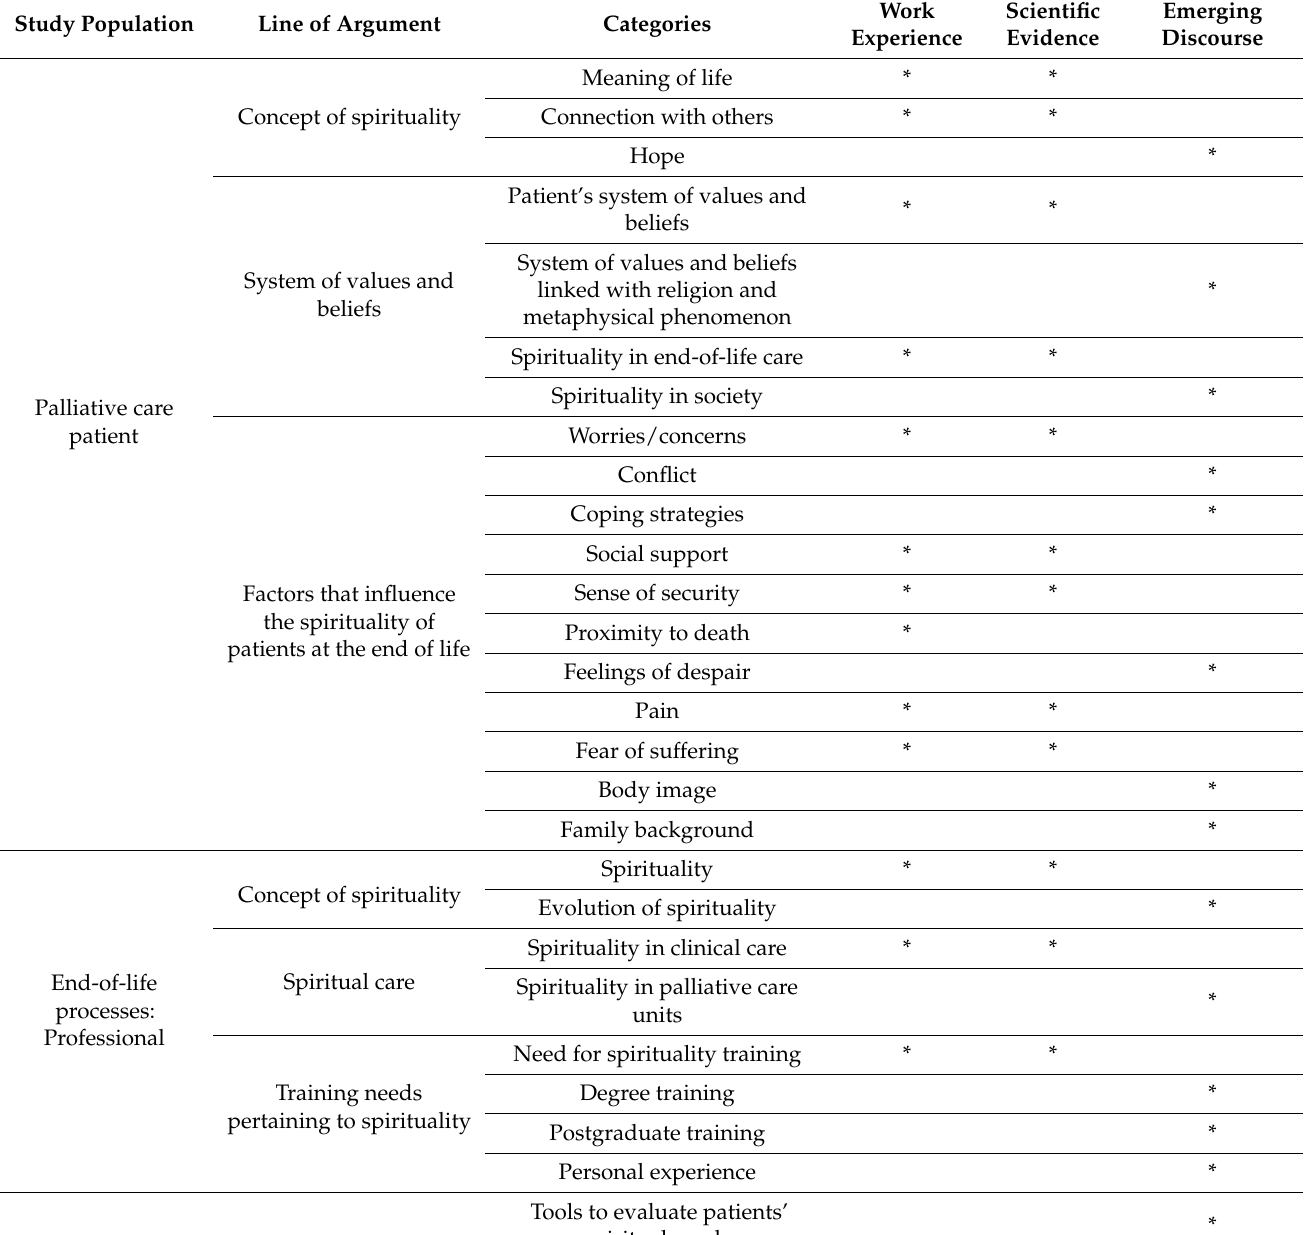
Table 3. Origin of study categories and subcategories according to population